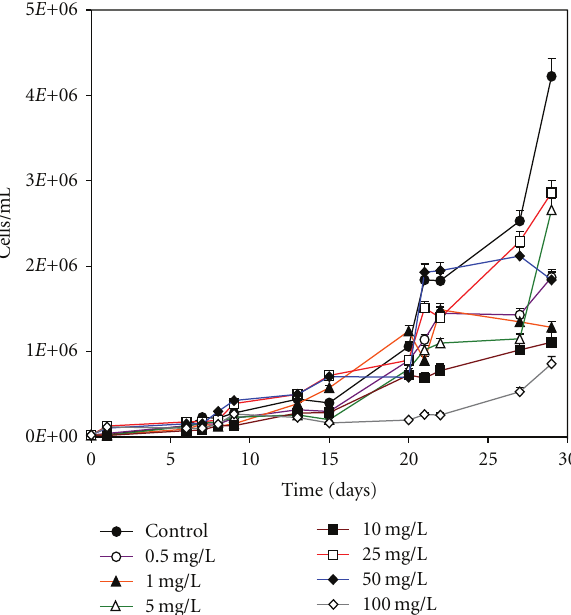
Figure 2: Growth curves of Monoraphidium and Scenedesmus cells, at pH 6.0 and 8.0 in ASM-1 culture medium.